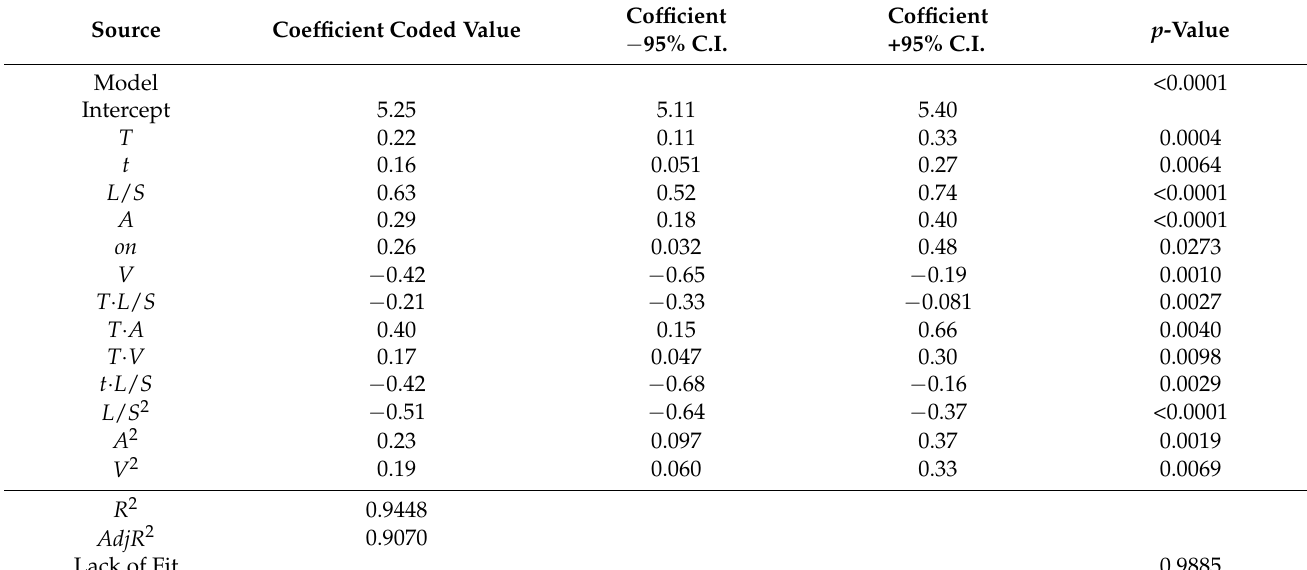
Table 4. Model for antiradical power ( ARP ) as a function of input variables and analysis of